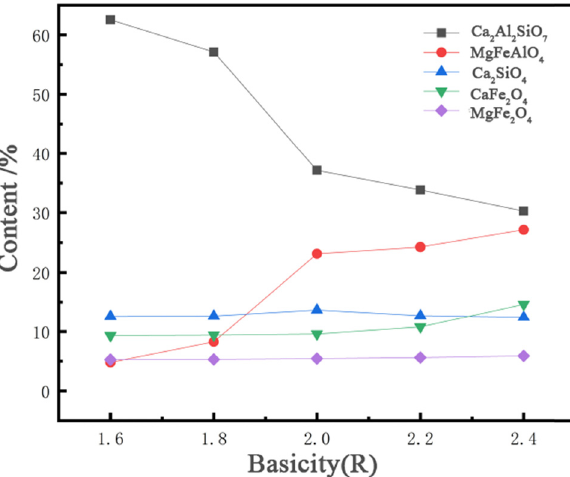
Figure 7: Composition and content of roasting mixed slag with dif - ferent basicities calculated by the binary method.